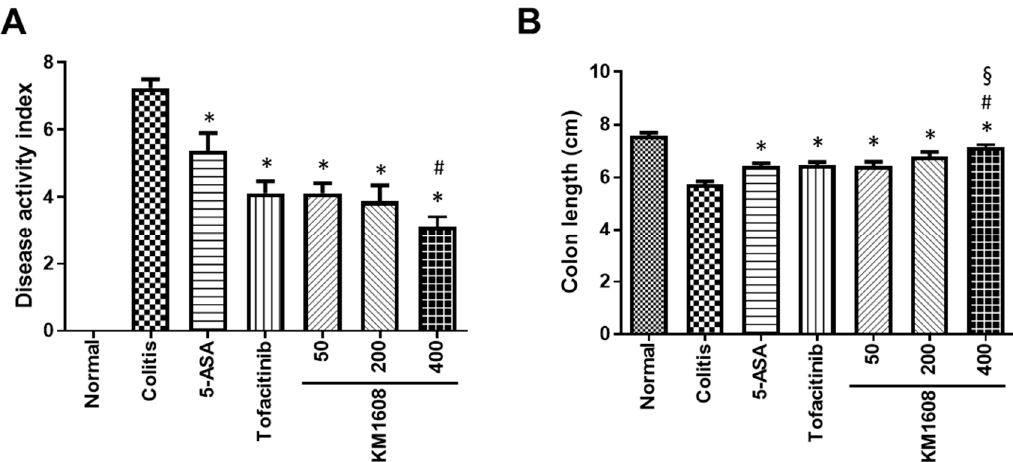
Figure 2. KM1608 improves the symptoms of DSS-induced colitis. Animals were treated with KM1608 (50, 200, and 400 mg/kg), 5-ASA (200 mg/kg), and tofacitinib (10 mg/kg) orally once a day. 5-ASA and tofacitinib were used as reference drugs. The disease activity index (DAI) was scored on Day 7 ( A ). Colon length was measured at autopsy on Day 7 ( B ). Data are presented as the mean ± SEM. n = 8. * p < 0.05 vs. colitis. # p < 0.05 vs. 5-ASA. § p < 0.05 vs. tofacitinib.